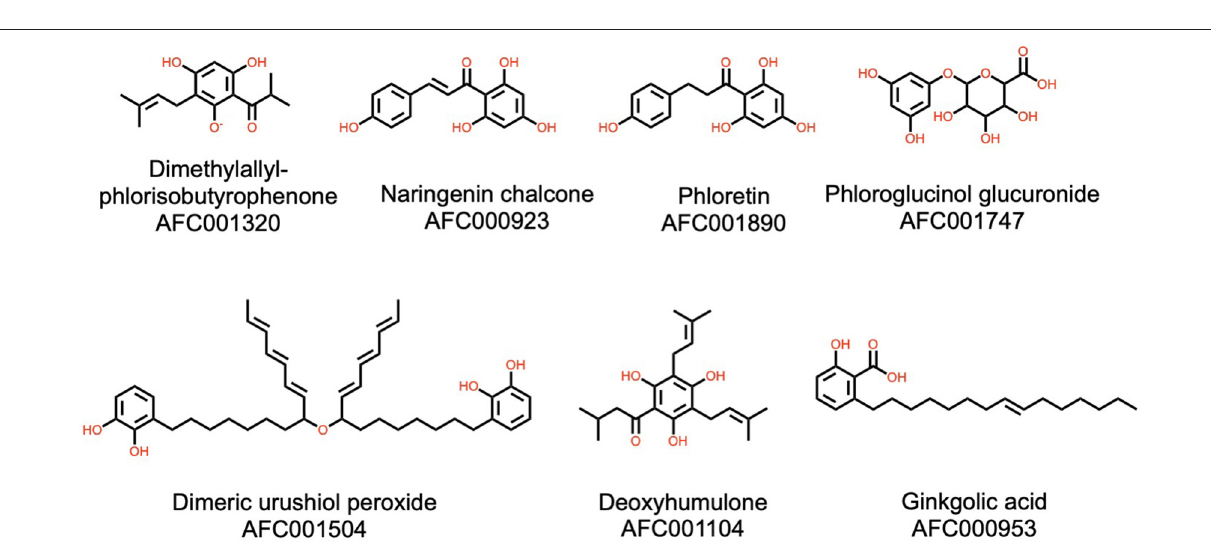
FIGURE 8 | Examples of the type III polyketides, catechols, phloroglucinols, and chalcones, present in watermelon. AFC identifiers are defined in Materials and Methods, section AFC